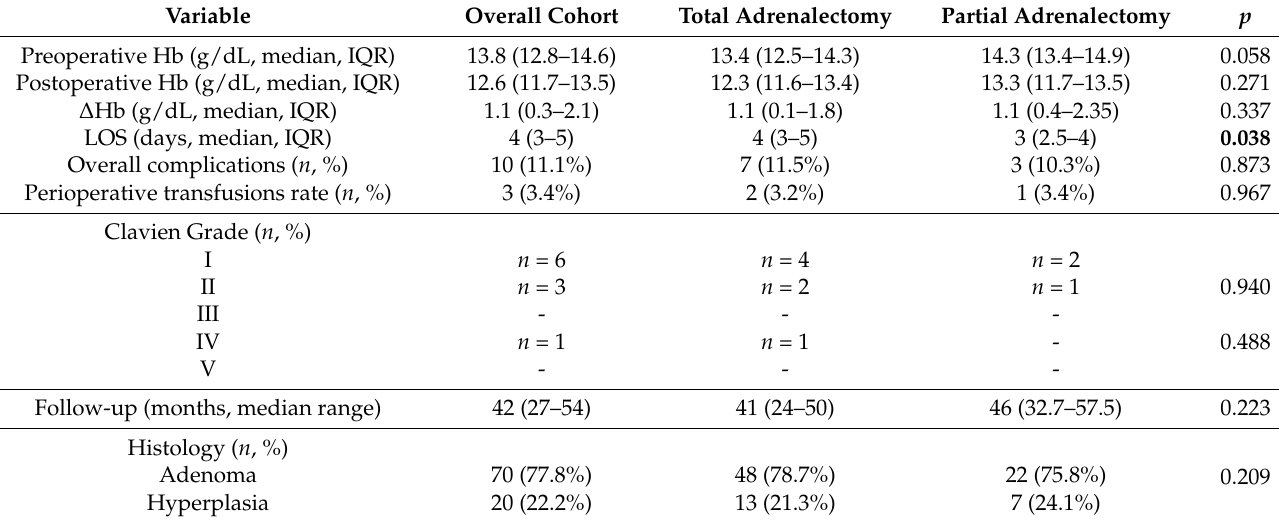
Table 2. Perioperative and pathologic